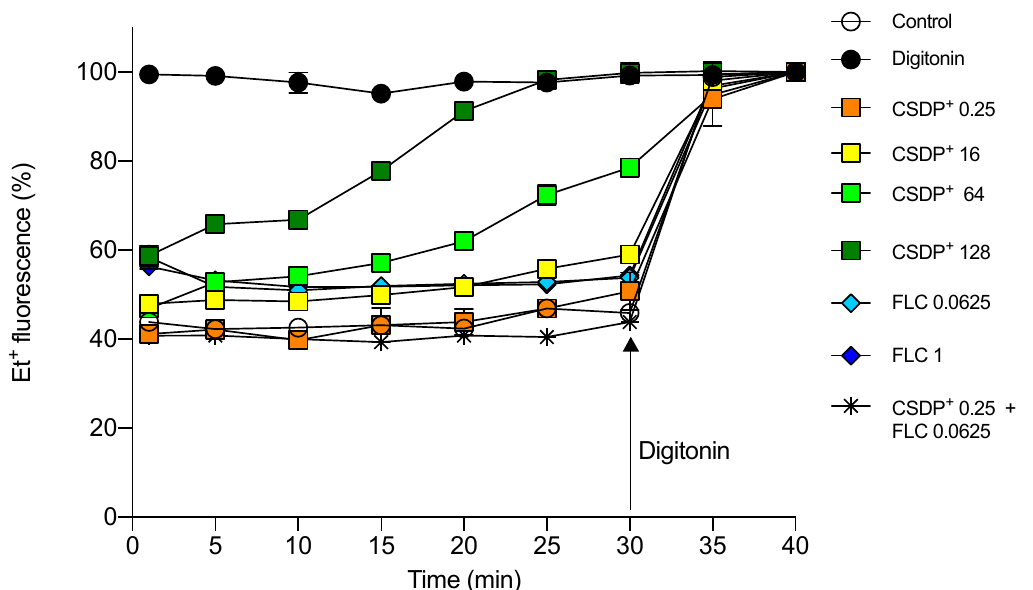
Figure 3. Et + fluorescence in HEK-293 cell suspensions. Fluorescence of Et + was registered in the presence of different concentrations ( µ g/mL) of CSDP + and fluconazole (FLC). In control measurements, the cells were not treated with any compound or the medium contained 0.1 mg/mL of a lysing agent digitonin. Data are shown as mean ± standard deviation (SD).